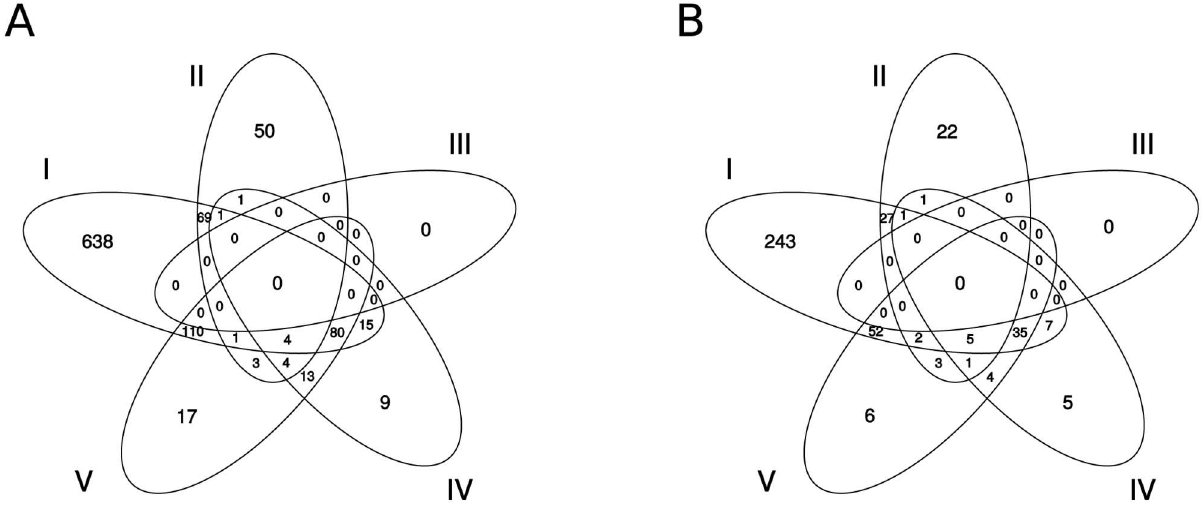
Fig 5. Differentially expressedKOs. Number of significantly differentially expressedproteins (adjusted p-value < 0.01) annotatedto (A) assembledtranscripts and to (B) KEGG Orthology identifiers per tested effect at time point 3. I-V represent tested effects accordingto Table